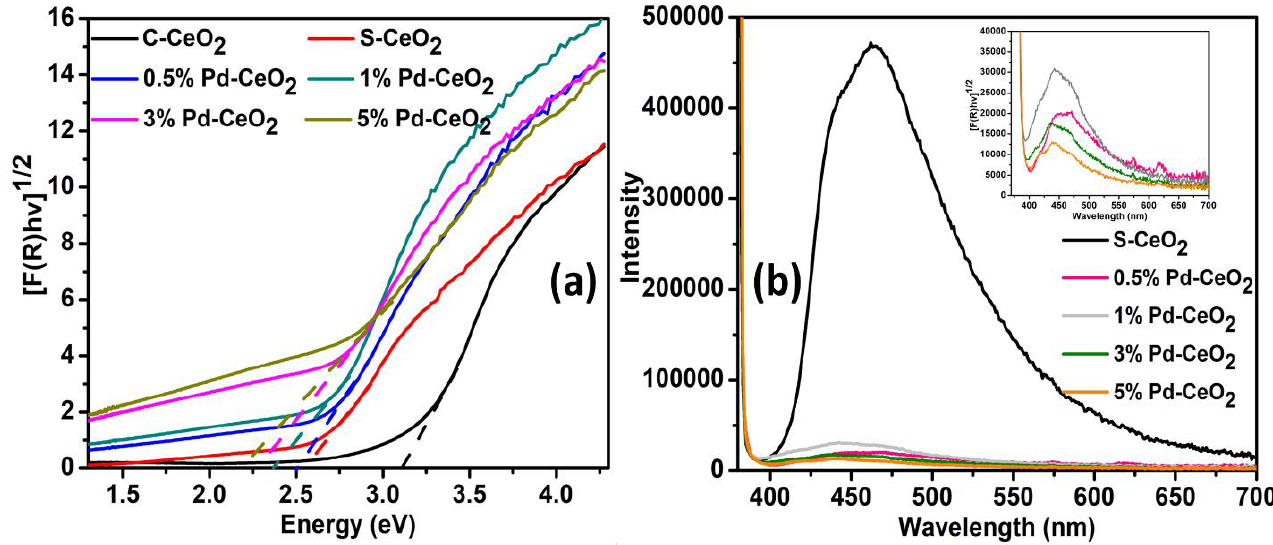
Figure 4. ( a ) Tauc plot derived from Kubelka-Munk function for band gap energy estimation, and ( b ) photoluminescence spectra of C − CeO 2 , S − CeO 2 , and Pd − CeO 2